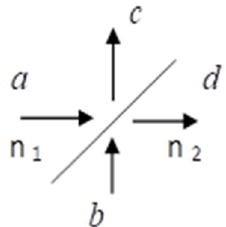
Figure 3. A typical dielectric interface beam splitter. Photons arrive simultaneously at the diagonal boundary interface n 2 > n 1 . The arrows correspond to converging and diverging waveguides of an X-junction.